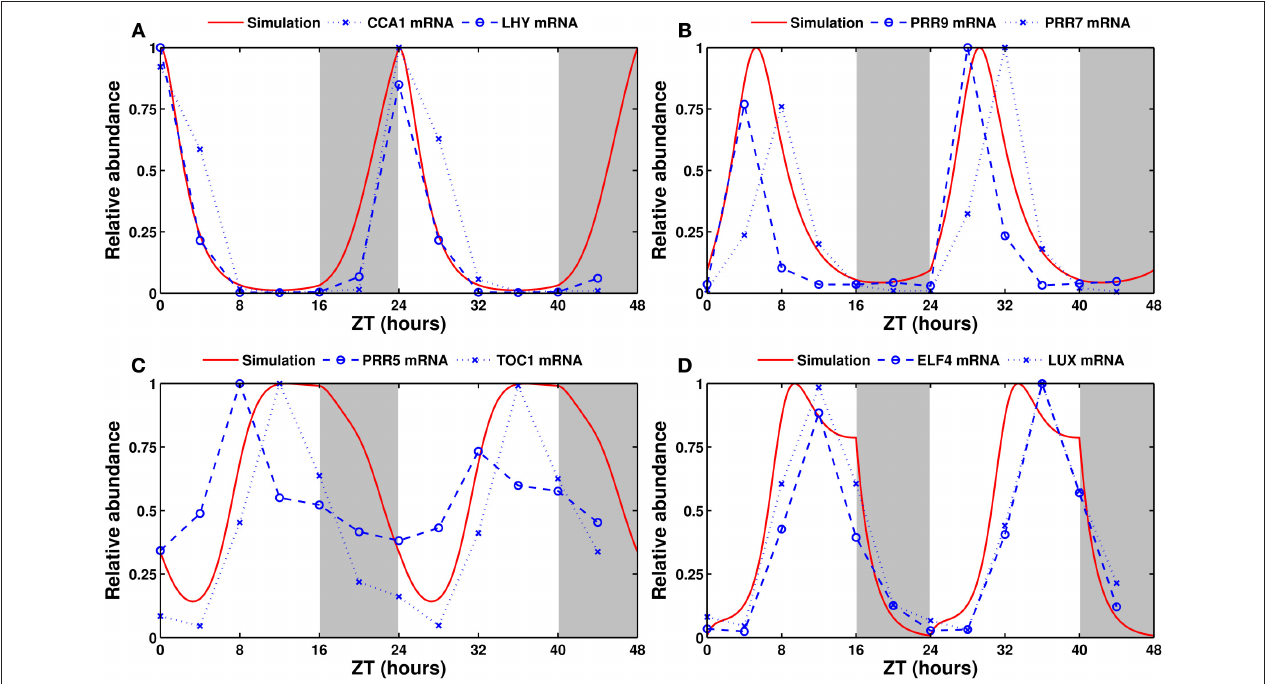
FIGURE 3 | Experimental and simulated expression profiles in long days (16L:8D). Experimentally measured (in blue) and simulated (in red) mRNA levels of (A) CCA1 and LHY , (B) PRR9 and PRR7 , (C) PRR5 and TOC1 , and (D) ELF4 and LUX . All values are normalized to their respective maximum. The experimental data was obtained from the DIURNAL database ( Mockler et al.,